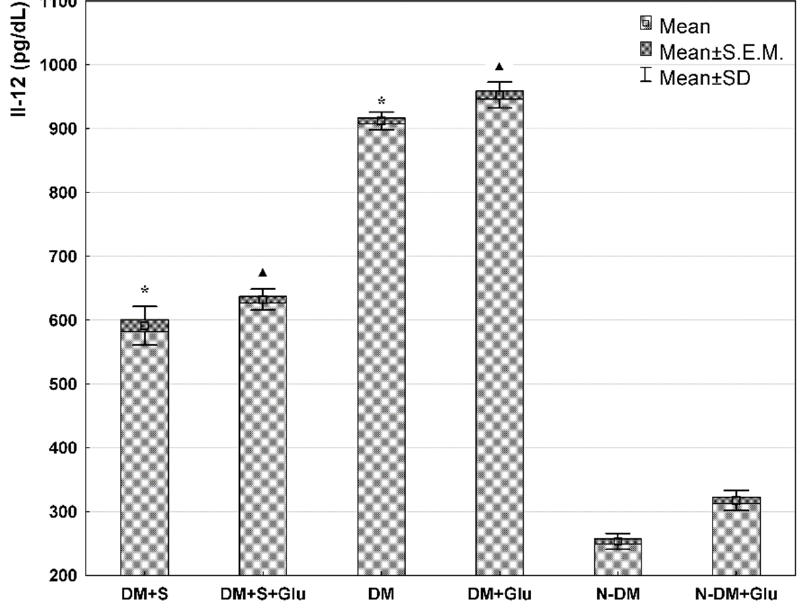
Figure 3. IL-12 level in the supernatant from a culture of human PBMCs isolated from statin-treated or statin-free type 2 diabetic patients, or from non-diabetic controls in the medium only, or preincubated with glucose (ANOVA). *—statistically significant difference compared with other groups at basic conditions, for p ≤ 0.05 ; ▲ —statistically significant difference compared with other groups in the presence of glucose, for p ≤ 0.05.